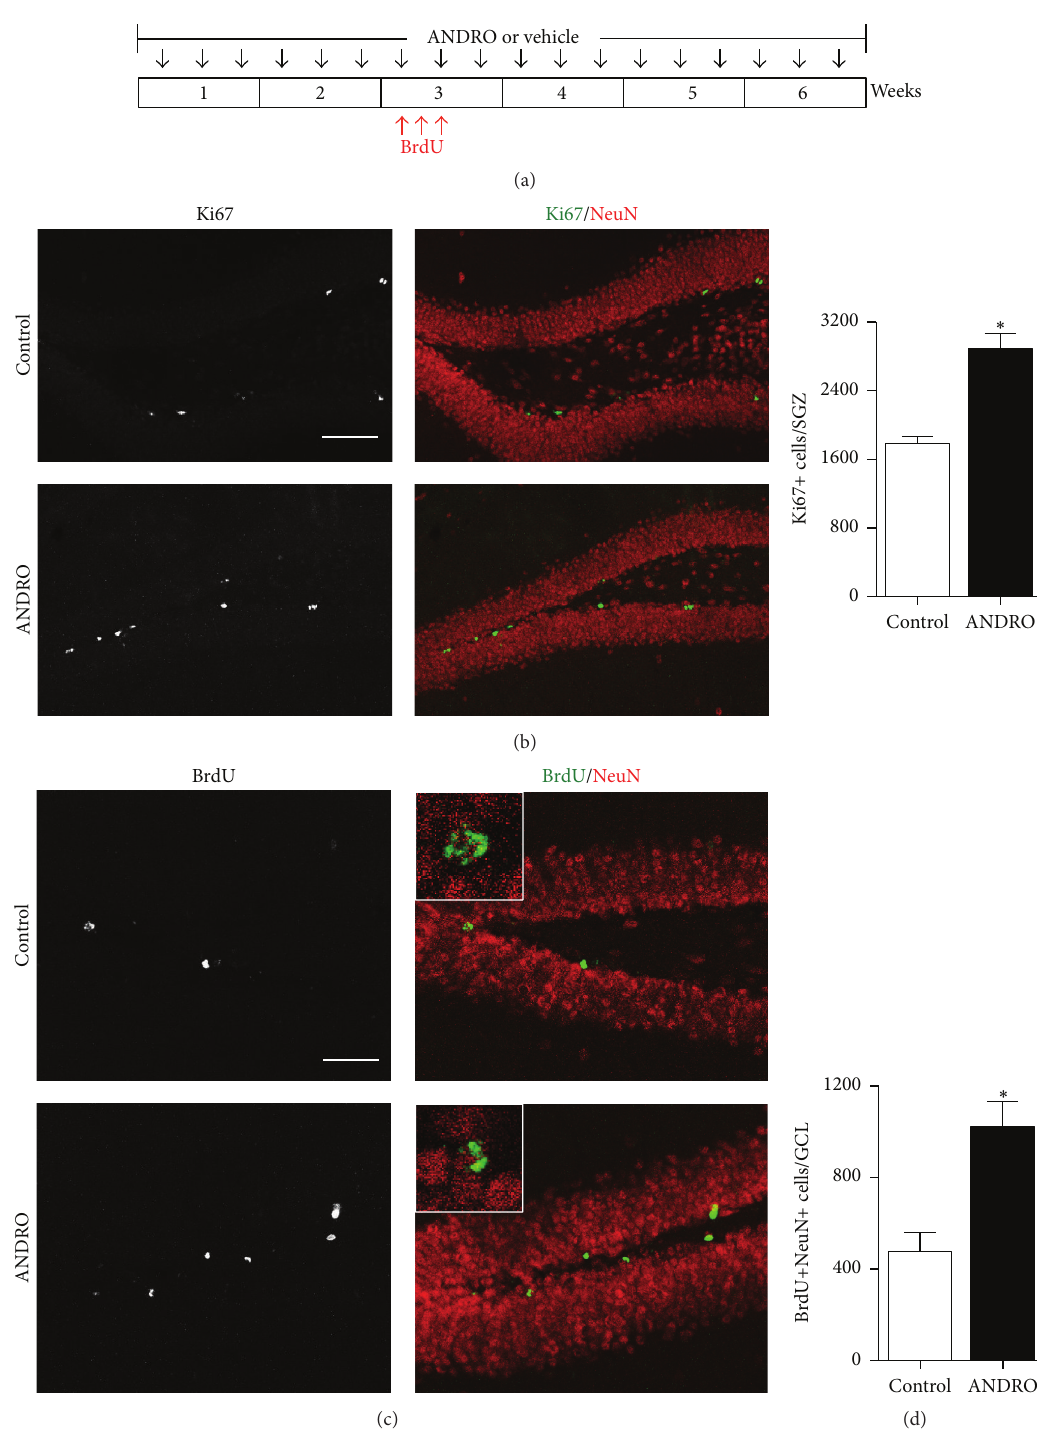
Figure 4: ANDRO increases the generation of newborn granule cells in the hippocampus of adult mice. (a) Schematic representation of the experimental procedure. Two-month-old mice were injected i.p. with 2mg kg −1 ANDRO or vehicle as control 3 times a week for 2 weeks and thenreceivedadailyi.p.injectionof100 mg kg −1 BrdUfor3consecutivedaysandcontinuedwiththetreatmentsfor4weeks.(b)Representative immunostaining of Ki67 and NeuN after 6 weeks of treatment. Scale bar: 100 𝜇 m. The graph represents quantification of the total number of Ki67-positive (Ki67+) cells in the SGZ. (c) Representative immunostaining of BrdU and NeuN. Insets show higher magnifications of double- positive cells. Scale bar: 50 𝜇 m (d) Quantification of the total number of double-positive (BrdU+NeuN+) cells in the GCL of control and ANDRO-treated mice. Bars represent mean ± S.E. ( 𝑛 = 4 mice). ∗ 𝑃 < 0.05 , Student’s 𝑡